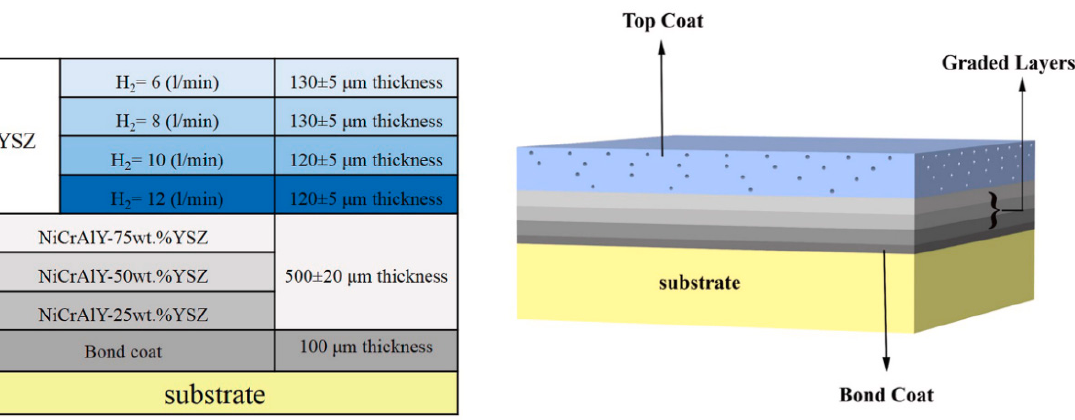
Figure 21. Schematic illustration of how the layers are arranged in the FGTTBC-PG and the parameters used to create these layers [147].